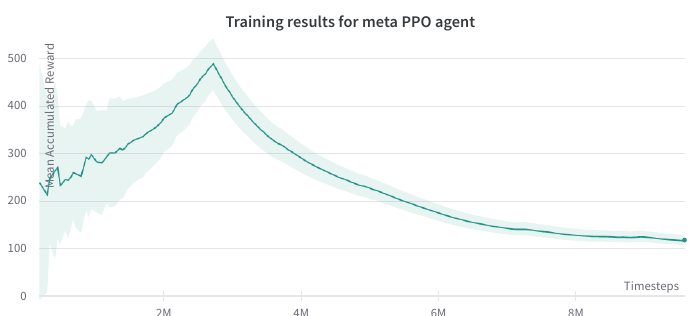
Figure 6. Progression of mean accumulated reward for the meta-agent with two low-level SAC agents. Training results are reported for three experiments with different random seeds. The standard deviation of three runs is shown in the